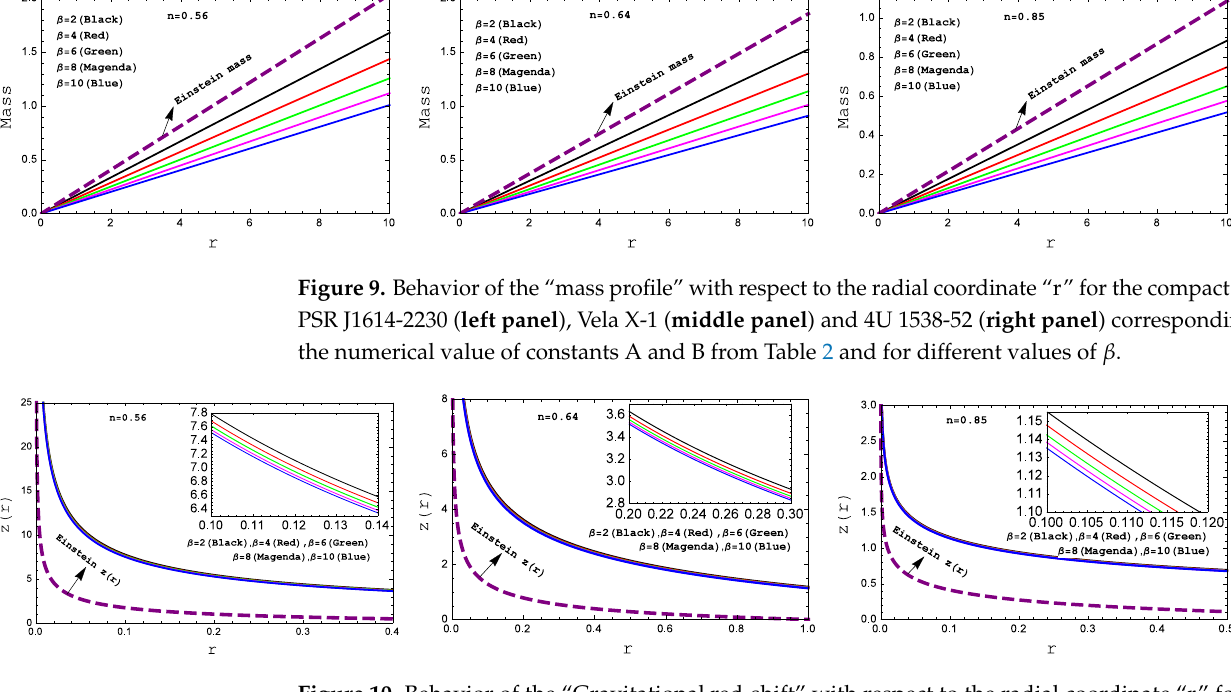
Figure 10. Behavior of the “Gravitational red-shift” with respect to the radial coordinate “r” for the compact stars PSR J1614-2230 ( left panel ), Vela X-1 ( middle panel ) and 4U 1538-52 ( right panel ) corresponding to the numerical value of constants A and B from Table 2 and for different values of β